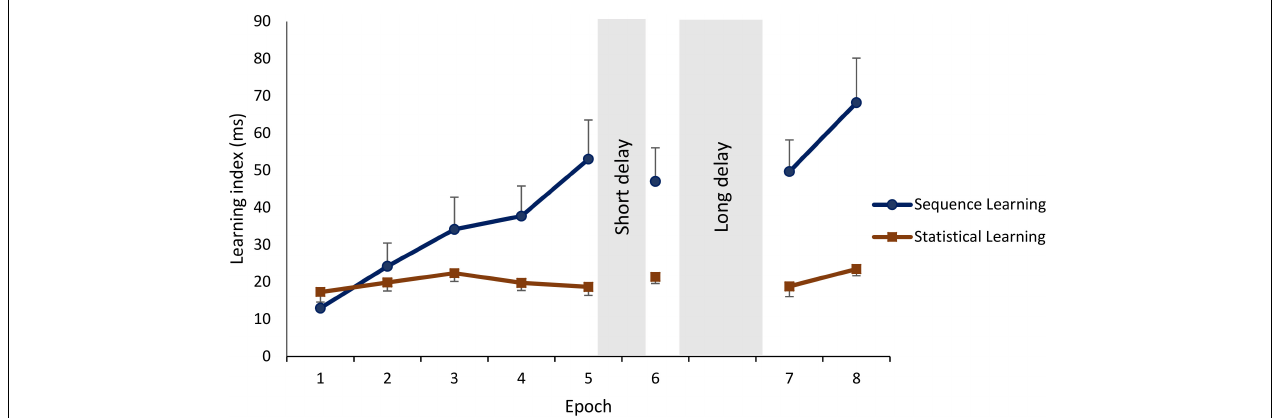
FIGURE 3 | Learning and off-line changes in Sequence and Statistical Learning. Sequence Learning is quantified as the difference in reaction times to random high elements vs. pattern elements. Statistical Learning is quantified as the difference in reaction times to random low elements vs. random high elements. Means and standard errors of Sequence Learning and Statistical Learning during each epoch. Sequence Learning exhibited a steep increase during training and additional practice after the off-line periods, whereas Statistical Learning remained unchanged throughout the sessions.